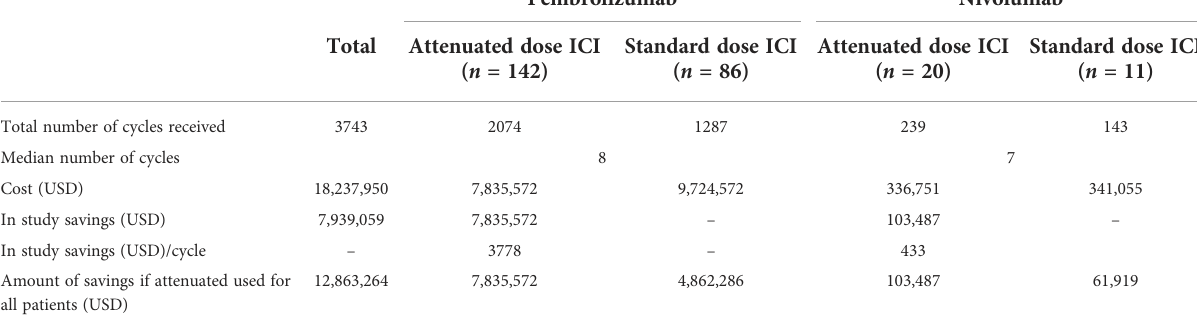
TABLE 6 Cost analysis of attenuated dose versus standard dose pembrolizumab and